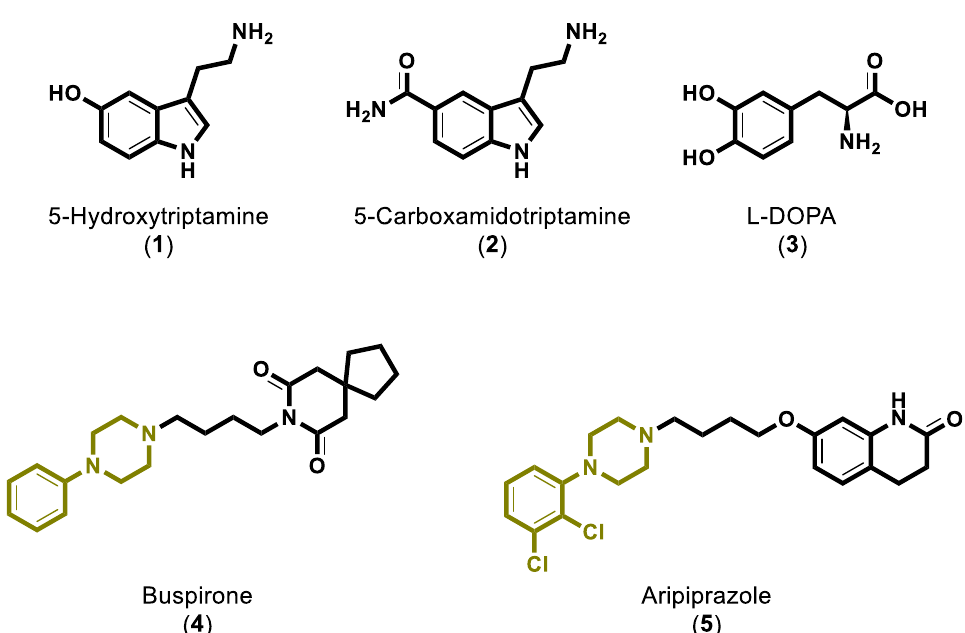
Figure 1. Chemical structures of serotonin and various arylpiperazine known inhibitors.